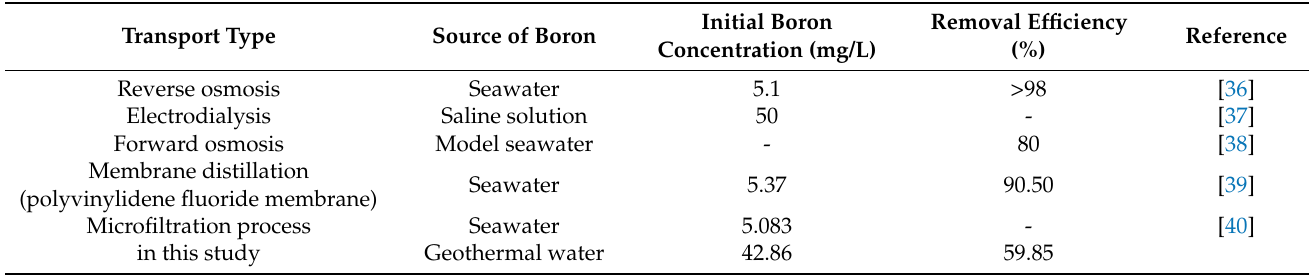
Table 7. Different techniques for separation of